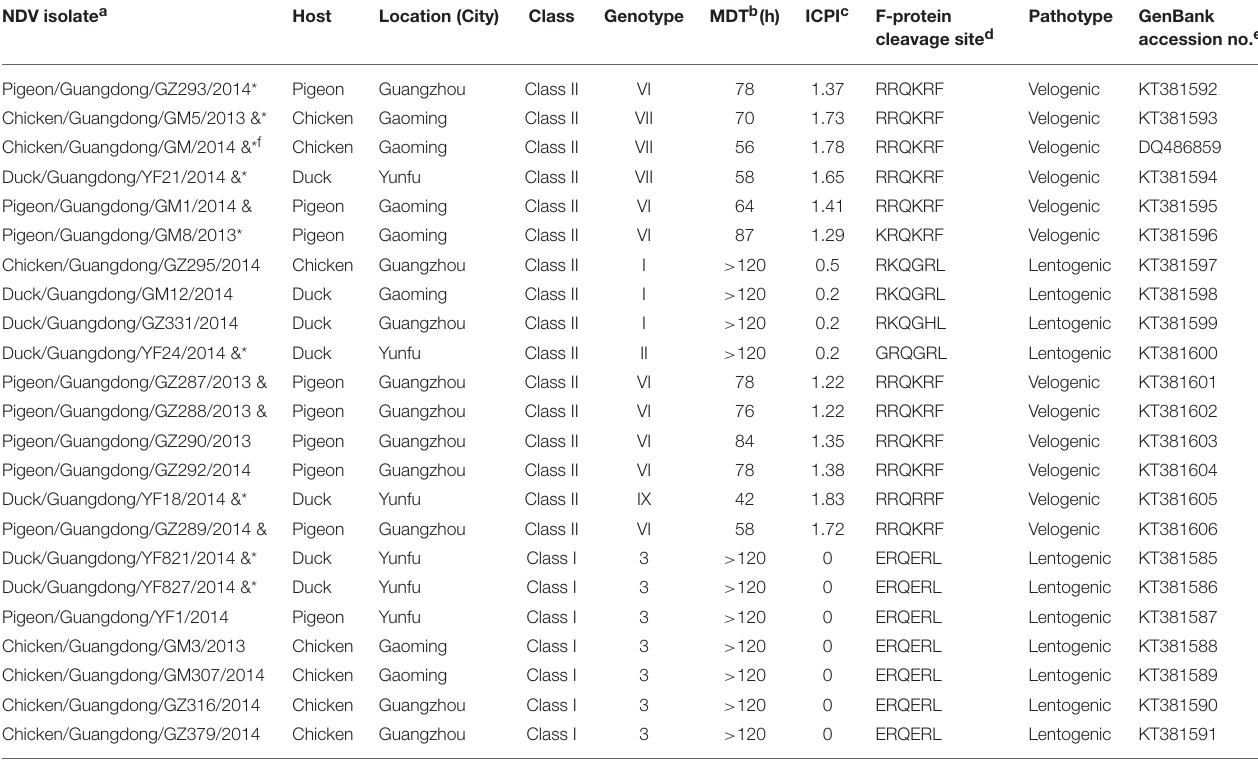
TABLE 1 | Epidemiological, genetic, and biological characteristics description of 23 NDVs isolated from South China. NDV isolate